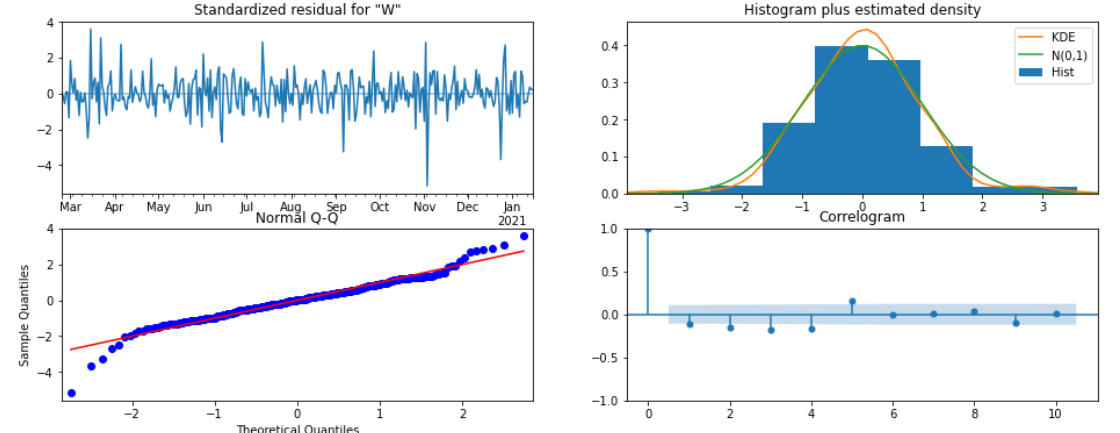
Figure 13. Residuals chart of SARIMAX model for walking in relation to school closing in